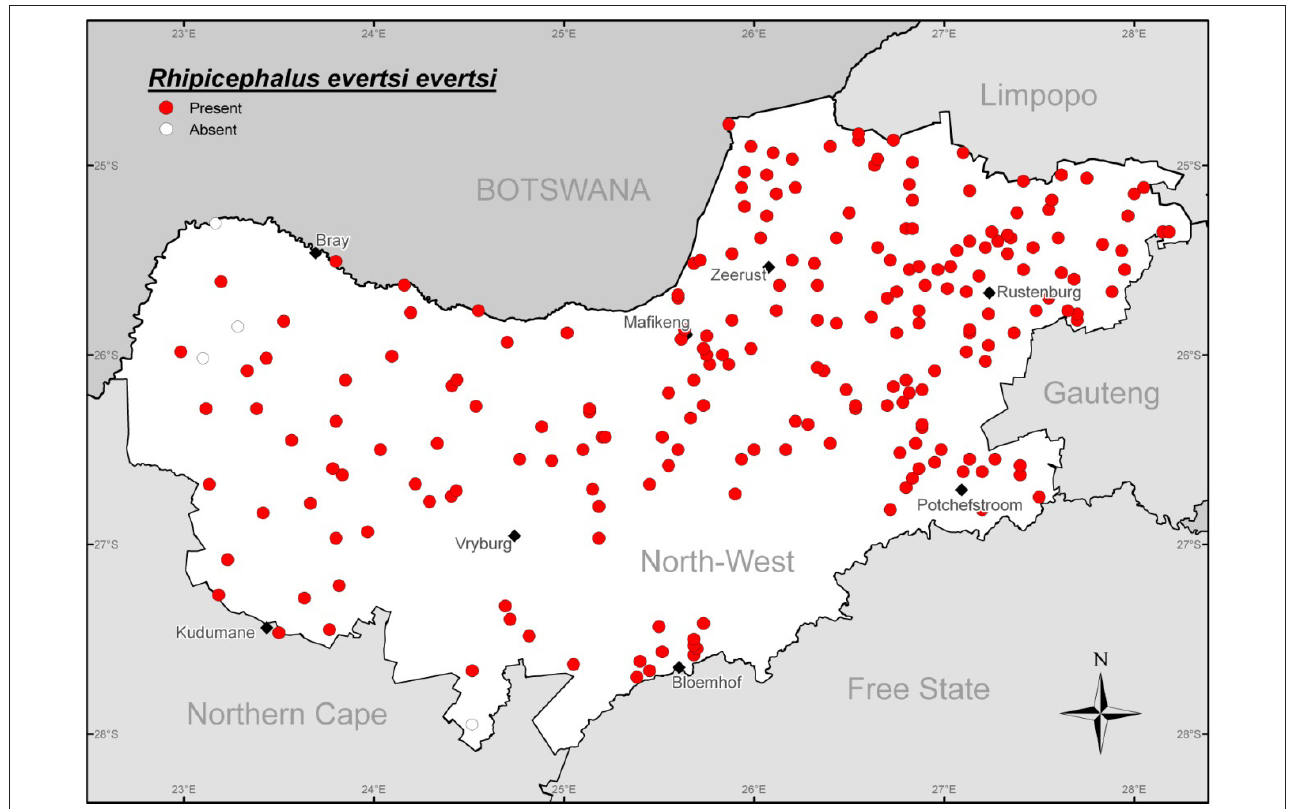
FIGURE 9: The geographic distribution of Rhipicephalus evertsi evertsi in the North West province, South